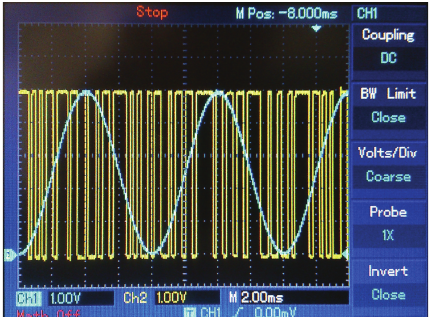
Figure 13: 125Hz sine wave message. Blue: sent message. Yellow: auxiliary signal 𝑠 1 (𝑘)